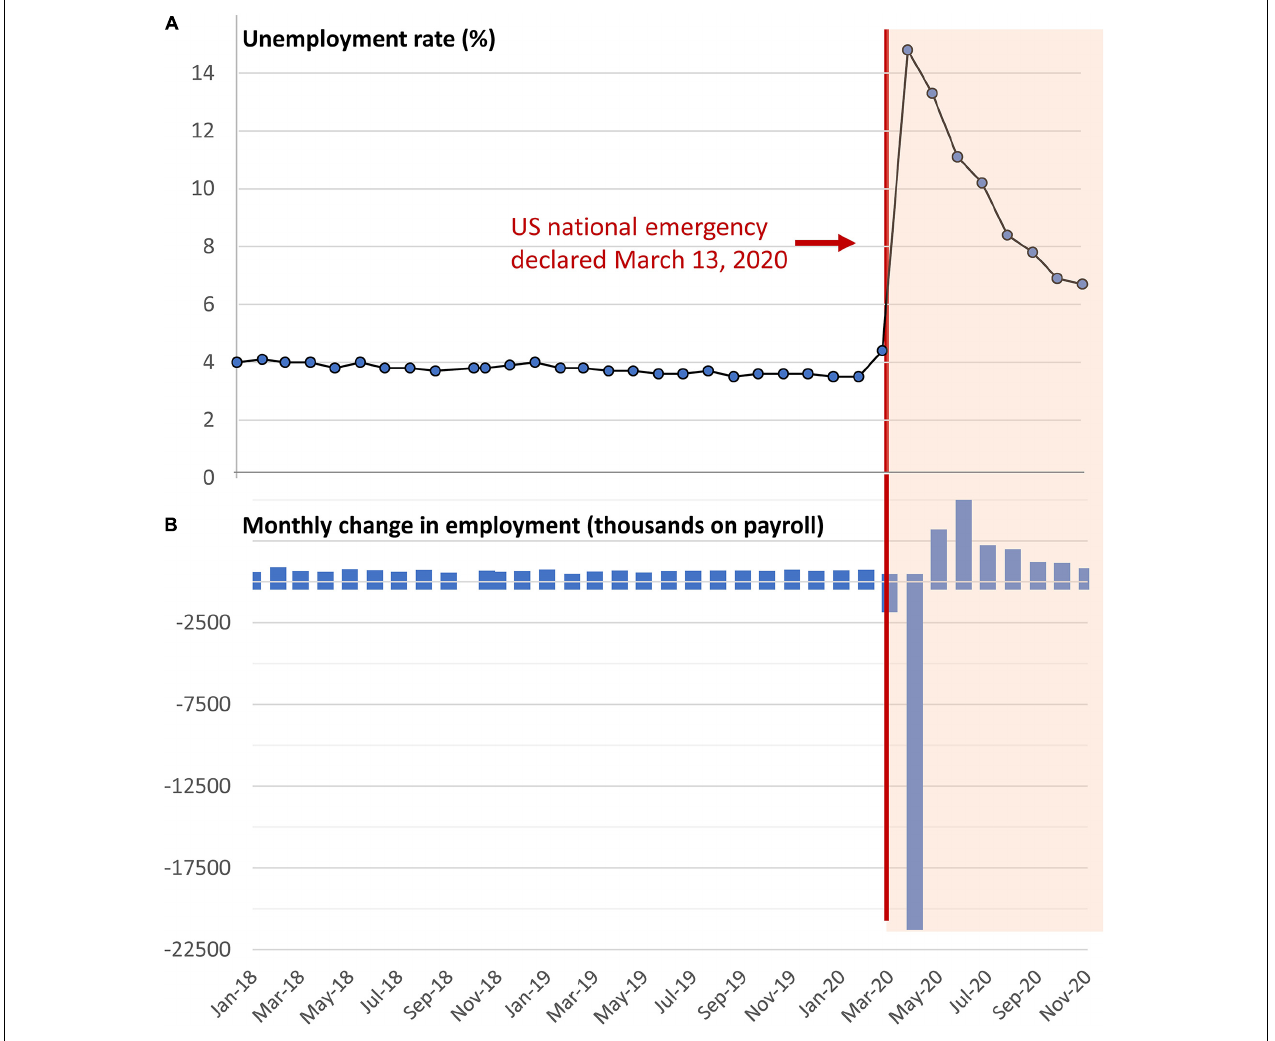
FIGURE 3 | (A) United States national monthly unemployment rate (%) and (B) monthly change in total non-farm employment (thousands of full-time equivalent employees on payroll) for 2018–2020 based on Bureau of Labor Statistics (US BLS, 2021a). Note that the unemployment rate does not include those people who are no longer eligible for unemployment benefits. The shaded areas indicate the period during which the COVID-19 pandemic